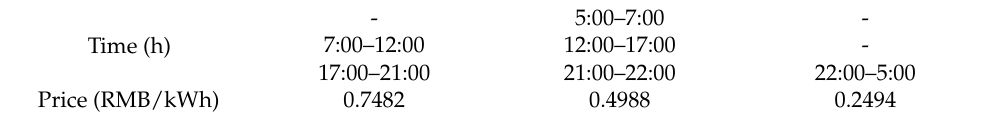
Table 1. 10 kv Electricity price basic data questionnaire in Liaoning province.